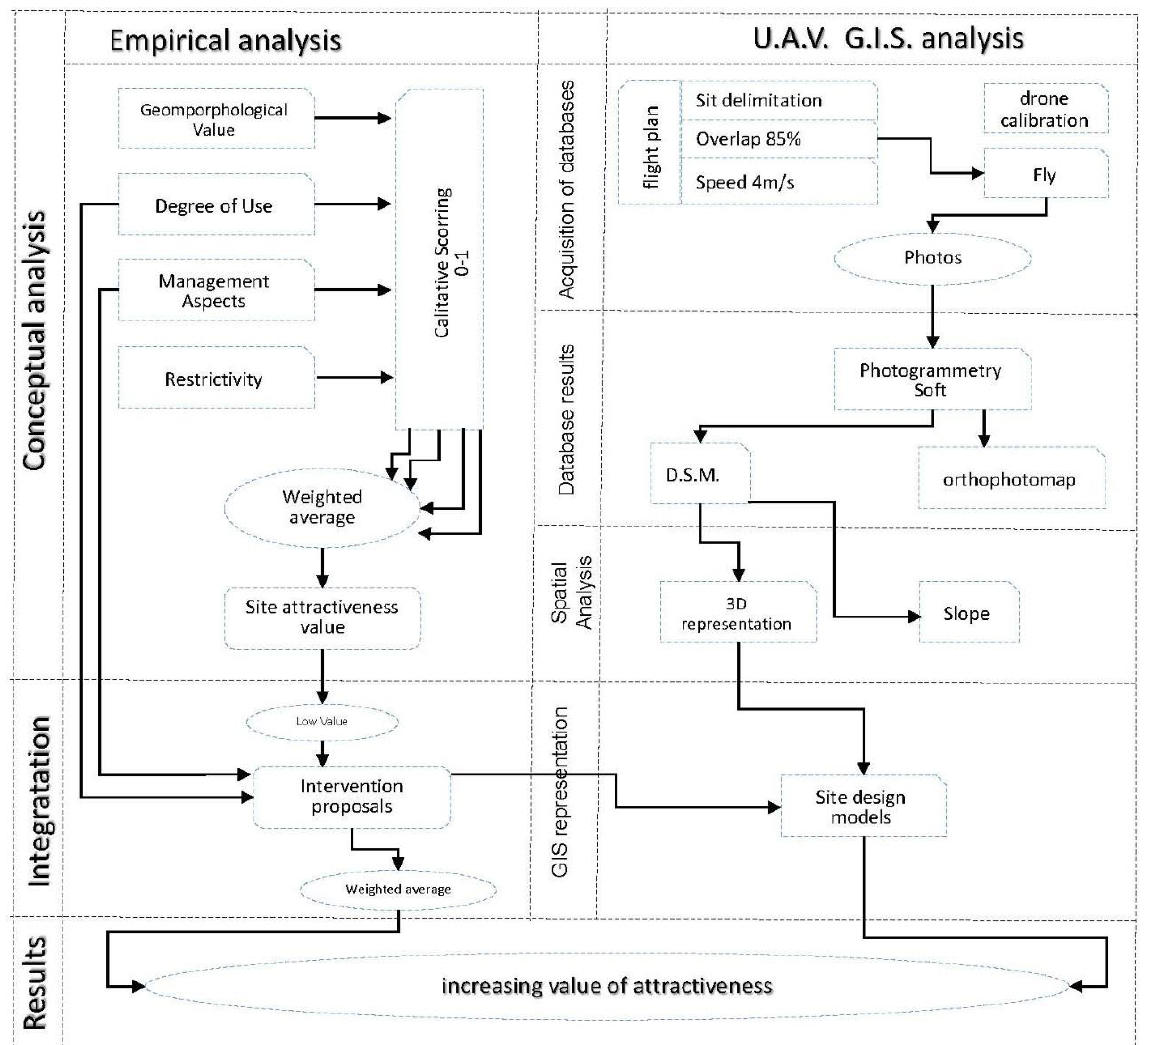
Figure 3. Methodological flowchart.